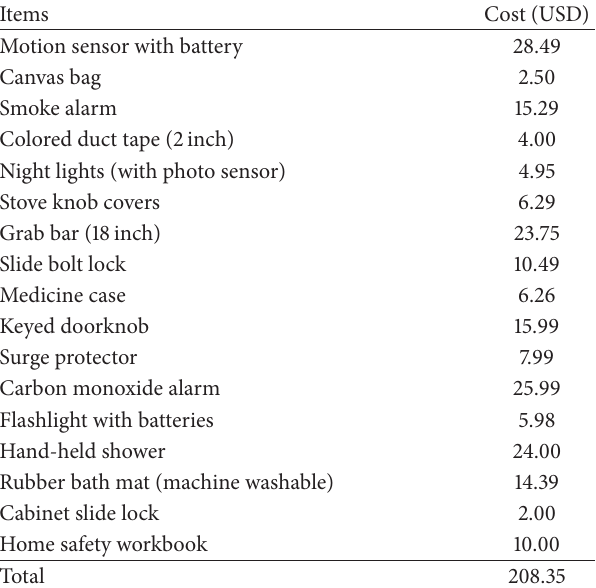
Table 1: Home safety